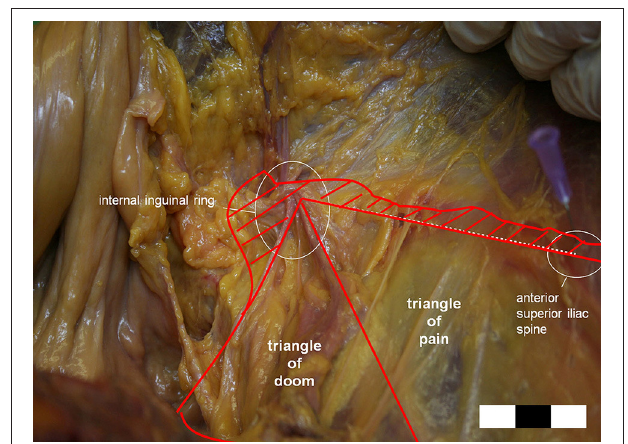
FIGURE 9 | The possible area of the genitofemoral nerve (GFN) or lateral femoral cutaneous nerve (LFCN) injury is larger than previously reported. (Hatched area: extension of the triangles of doom, and pain.) (Courtesy of Prof. Wolfgang